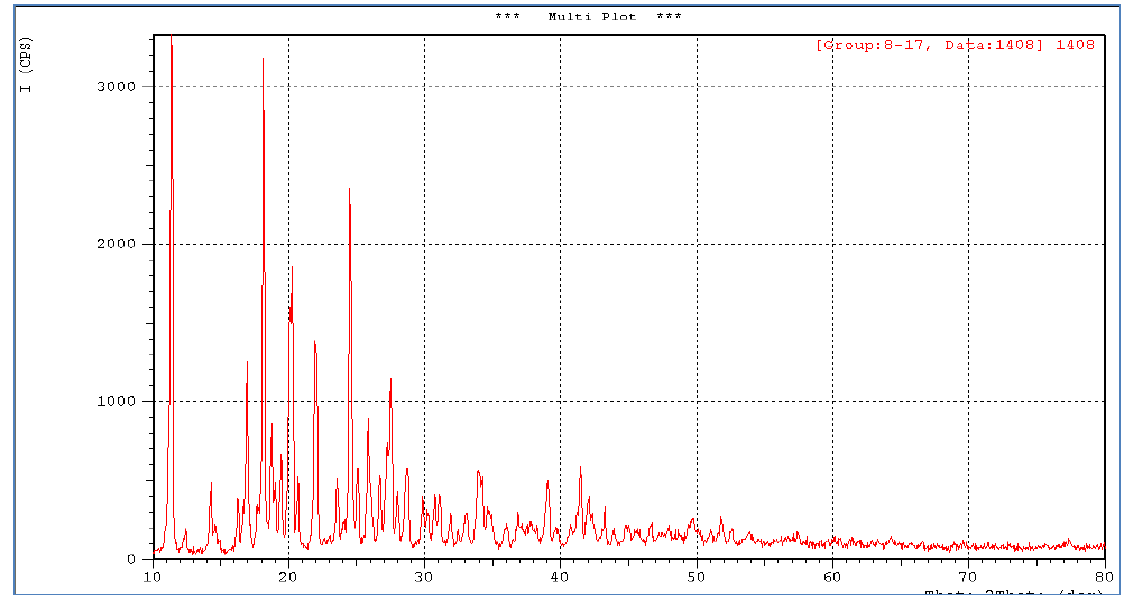
Figure 10. X – Ray diffractograms of darifenacin